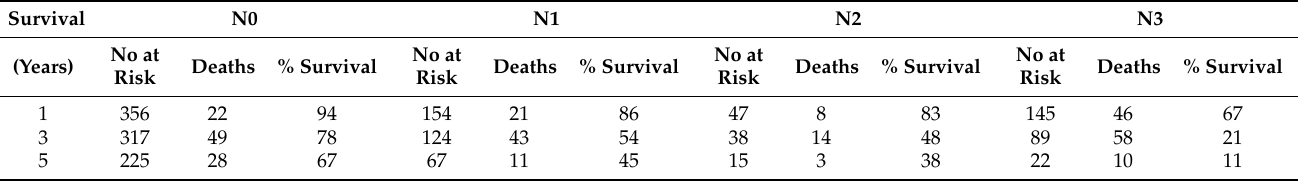
Table 3. Overall number of surviving OAC patients based on nodal status (pathological